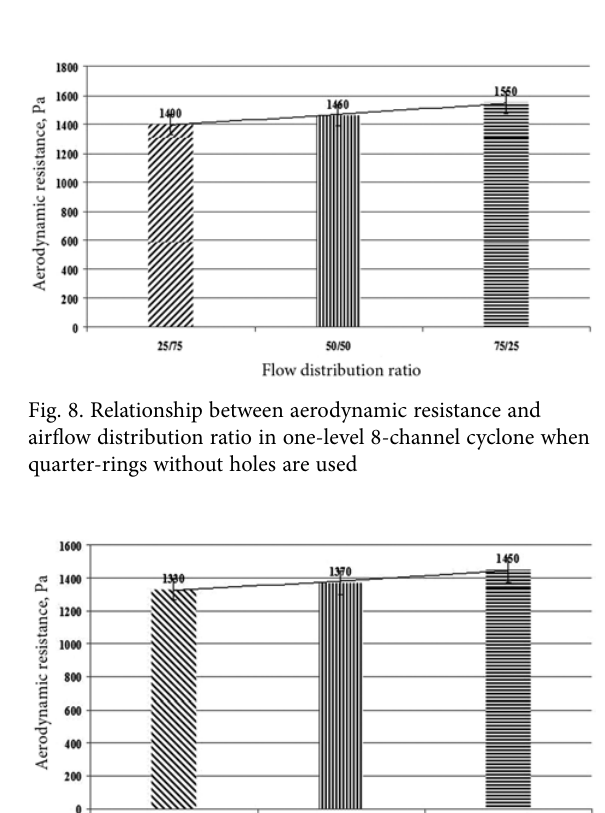
Fig. 7. Relationship between aerodynamic resistance and airflow distribution ratio in one-level cylindrical 8-channel cyclone by using curvilinear semi-rings